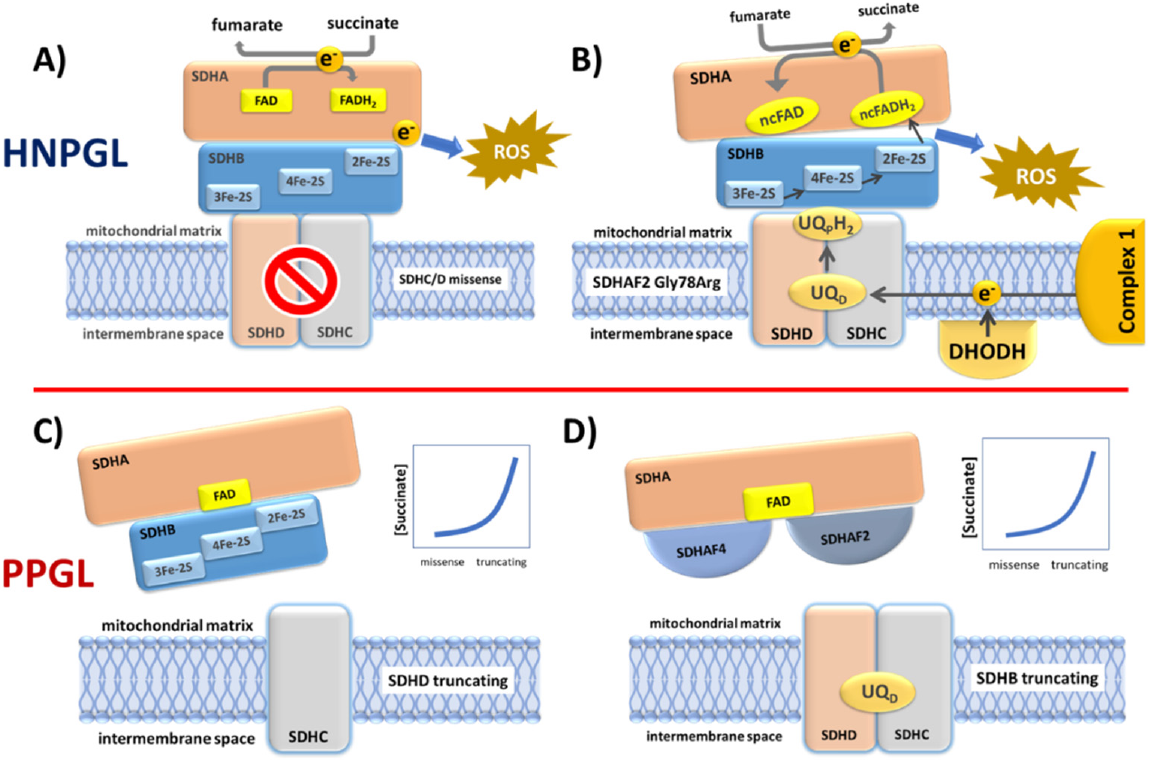
Figure 6. Four possible functional scenarios corresponding to the diverse SDH variant types. ( A )